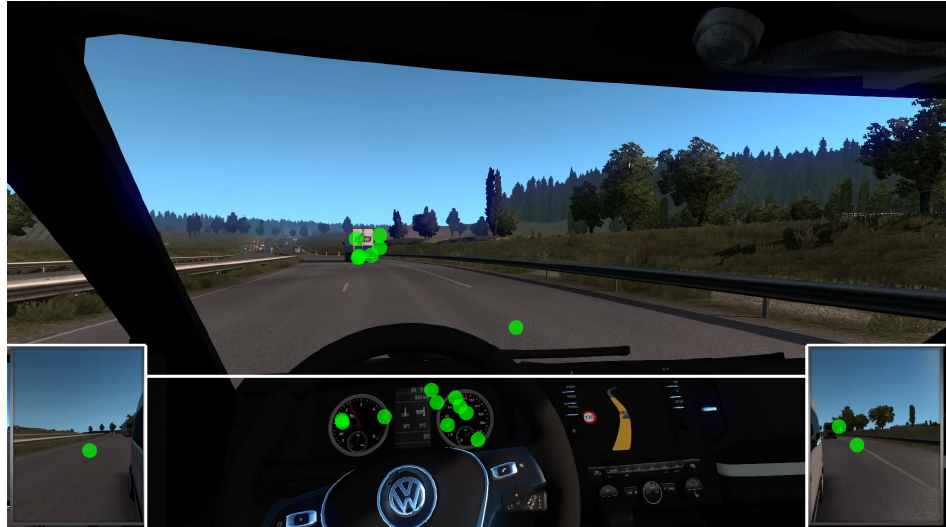
Figure 7. Moment in Video 3 where most participants attended to the dashboard (Baseline Task). The green markers represent the gaze coordinates of individual participants. White lines are drawn around the AOIs.